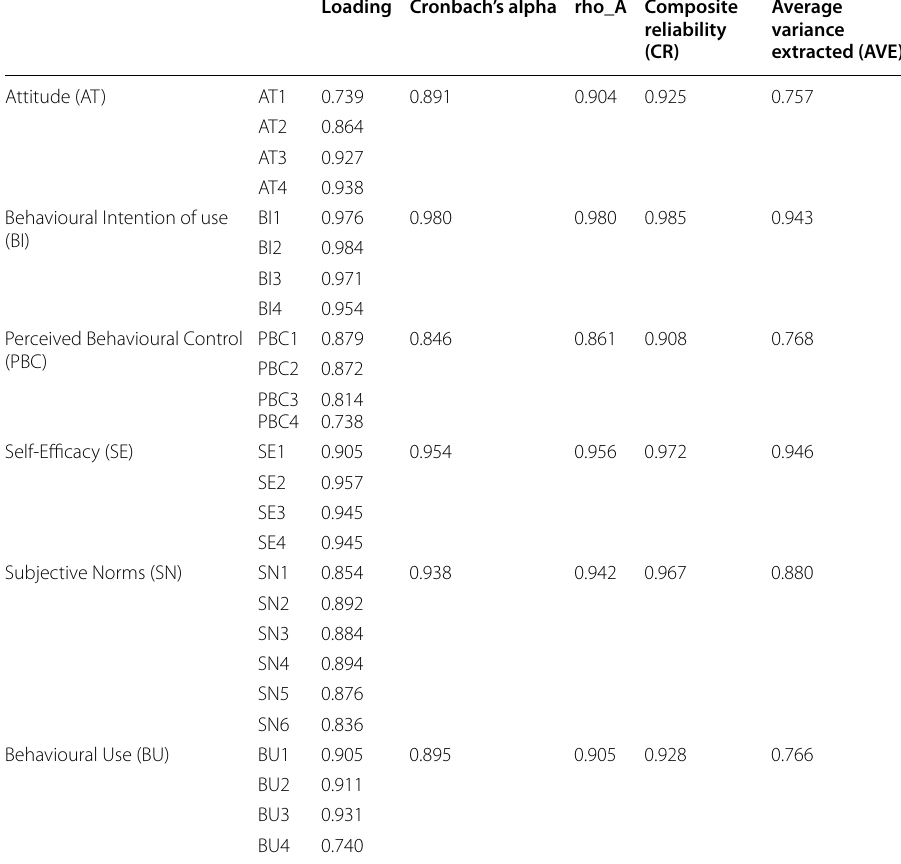
Table 4 Composite Reliability and Validity